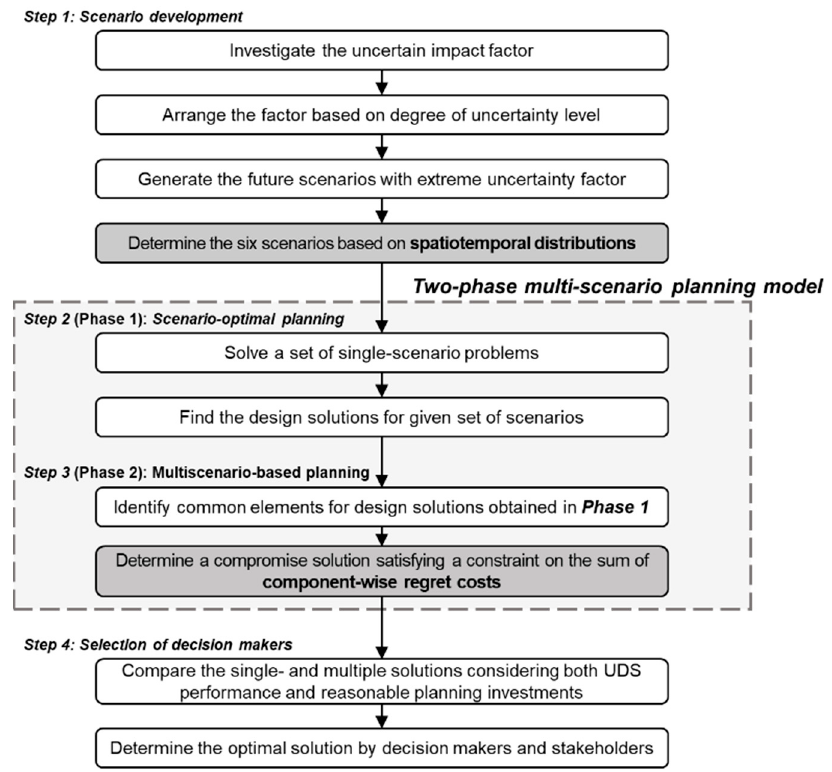
Figure 2. Flowchart of the proposed model.